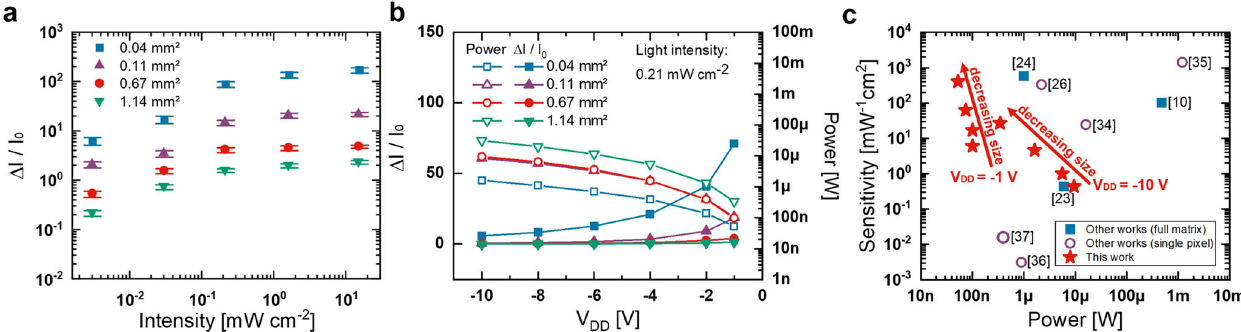
Fig. 4 Investigation on size and operational voltage. a Relative change in current versus light intensity for the integrated devices containing different OPD sizes, namely, 0.04. 0.11, 0.67, and 1.14 mm 2 (V DD = − 1 V; V GS = − 10 V). Error bars correspond to the standard deviation s.d. ( n = 3). b Relative change in current and power consumption versus anode-source voltage V DD at V GS = − 10 V for a light intensity of 0.21 mW cm − 2 . c Sensitivity versus power consumption for our work V GS = − 10 V (red stars) and for other works found in the literature. Filled symbols represent works where a full matrix was also achieved and un fi lled symbols represent works where only single pixels were